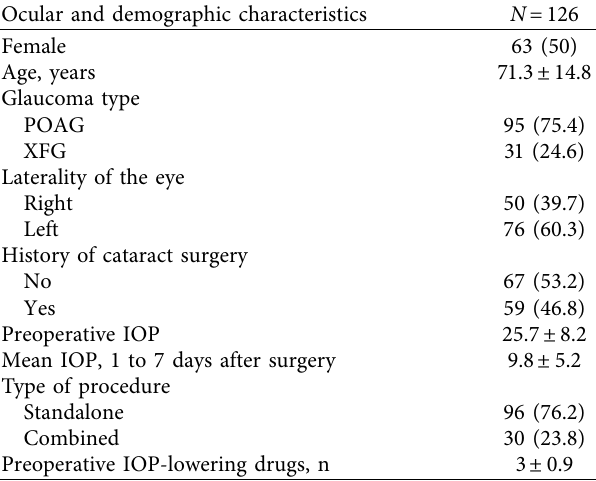
Table 1: Ocular, demographic, and perioperative characteristics. Ocular and demographic characteristics